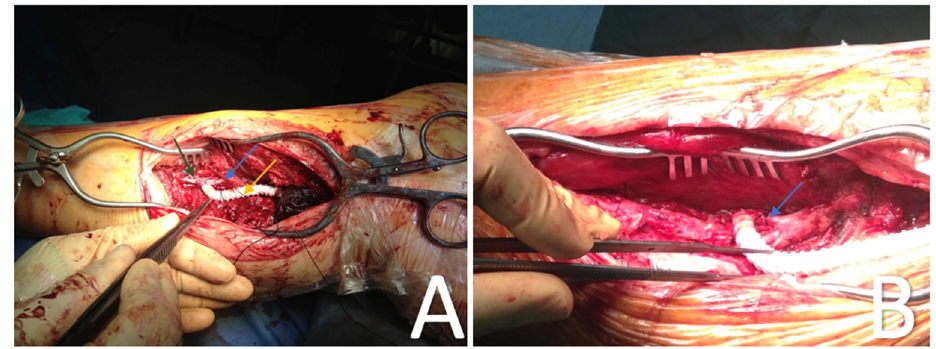
Figure 2. ( A ) Banding of the comitans vein with a silk suture. Green arrow: posterior tibial artery. Blue arrow: posterior tibial vein. Yellow arrow: PTFE graft. ( B ) Final result of AVF with a silk suture in the comitans vein.